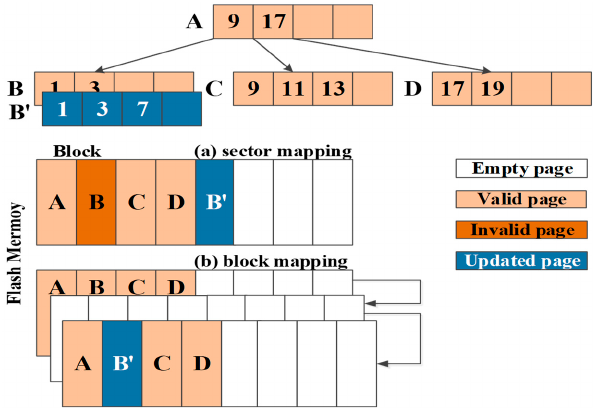
Figure 2. B-Tree on the flash storage device.